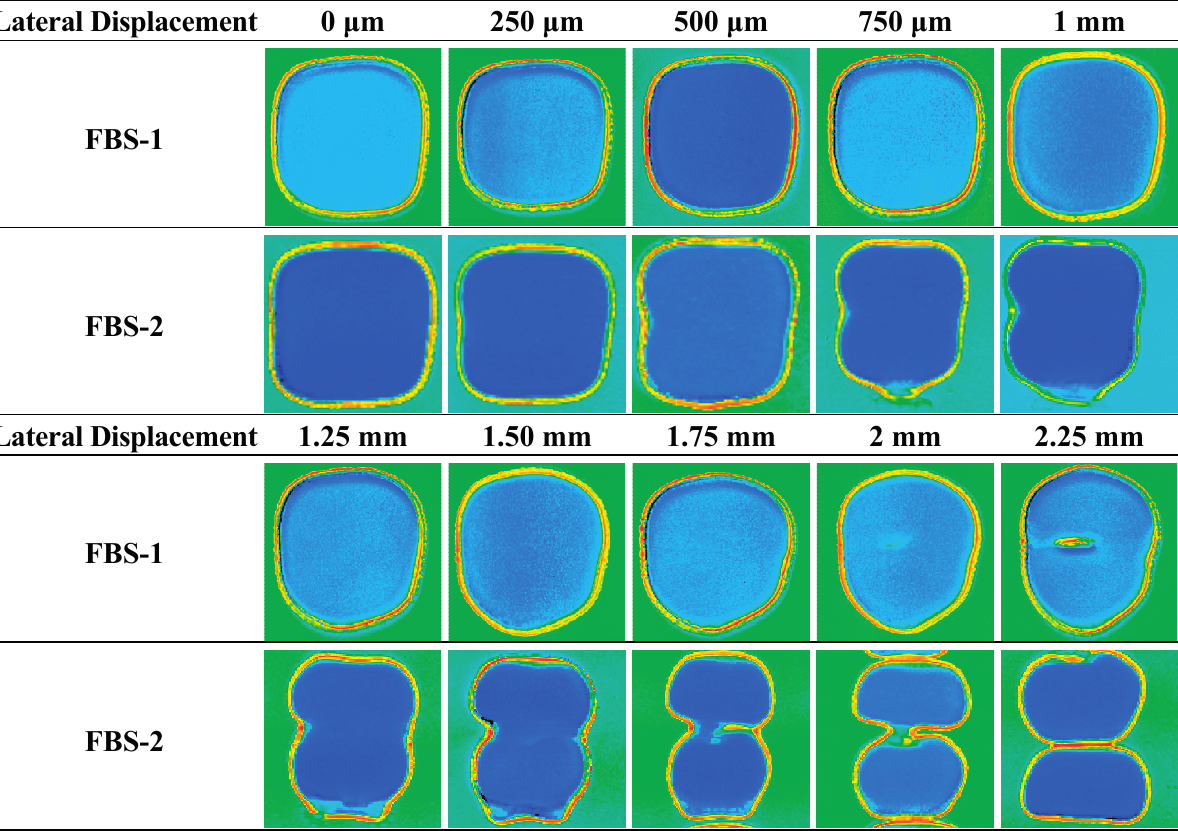
Table 1. Comparison of the ablated geometry for different lateral displacement values for FBS-1 and